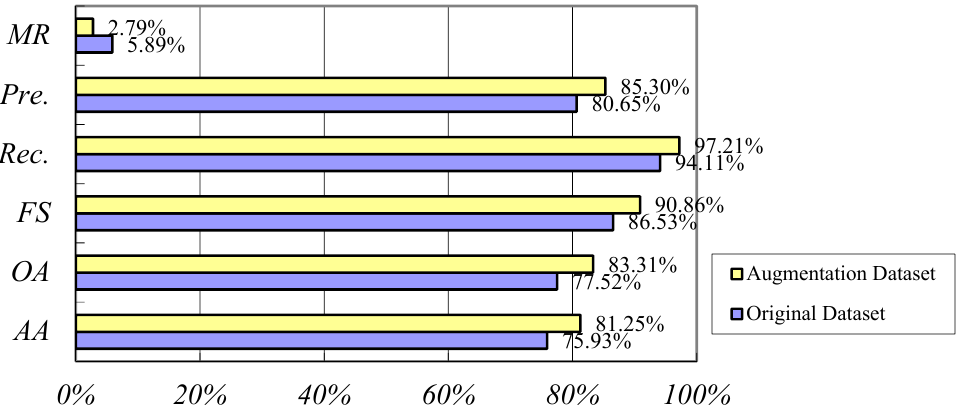
Figure 6. Comparison of the performance in different sizes of datasets via YOLO.